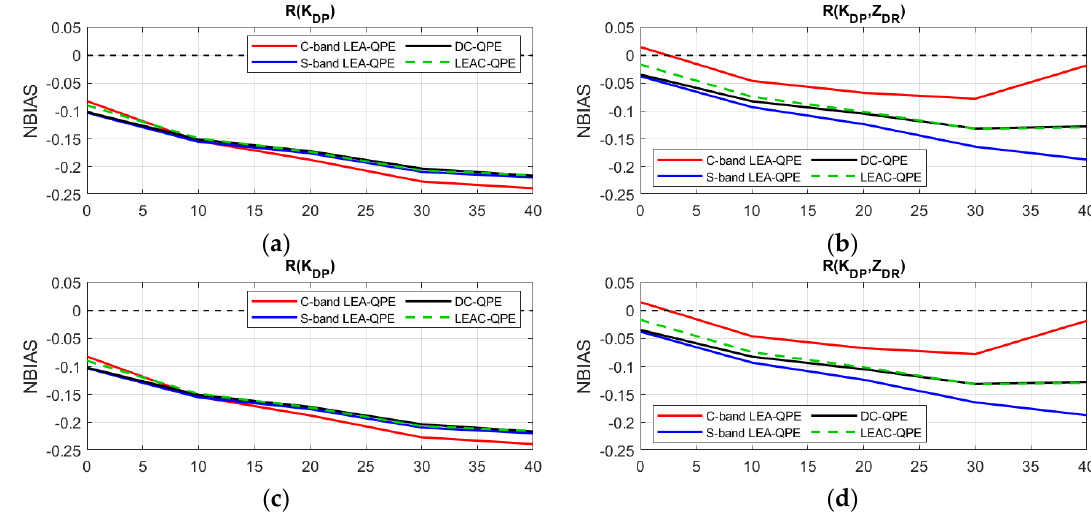
Figure 13. The NBIAS of C-/S-band LEA-QPE, DC-QPE and LEA DC-QPE (LEAC-QPE) derived from the ( a ) R(K DP ) and ( b ) R(K DP , Z DR ) algorithm. ( c ) and ( d ) are the same but showing NRMSE.